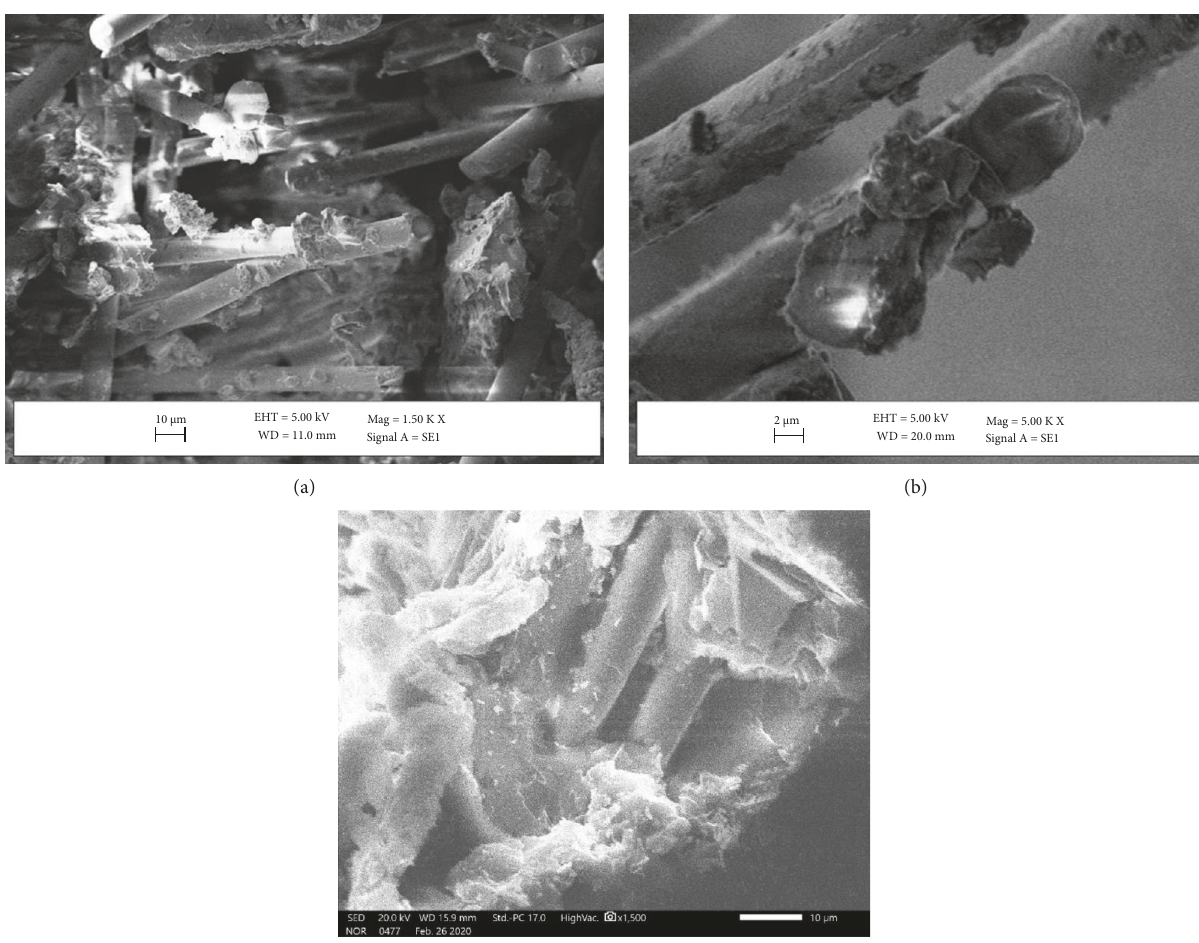
Figure 13: SEM of nanocarbon filler dispersed composite under erosion wear in (a) MWCNTs composite, (b) fibre pullout in erosion, and (c) filler dispersed in